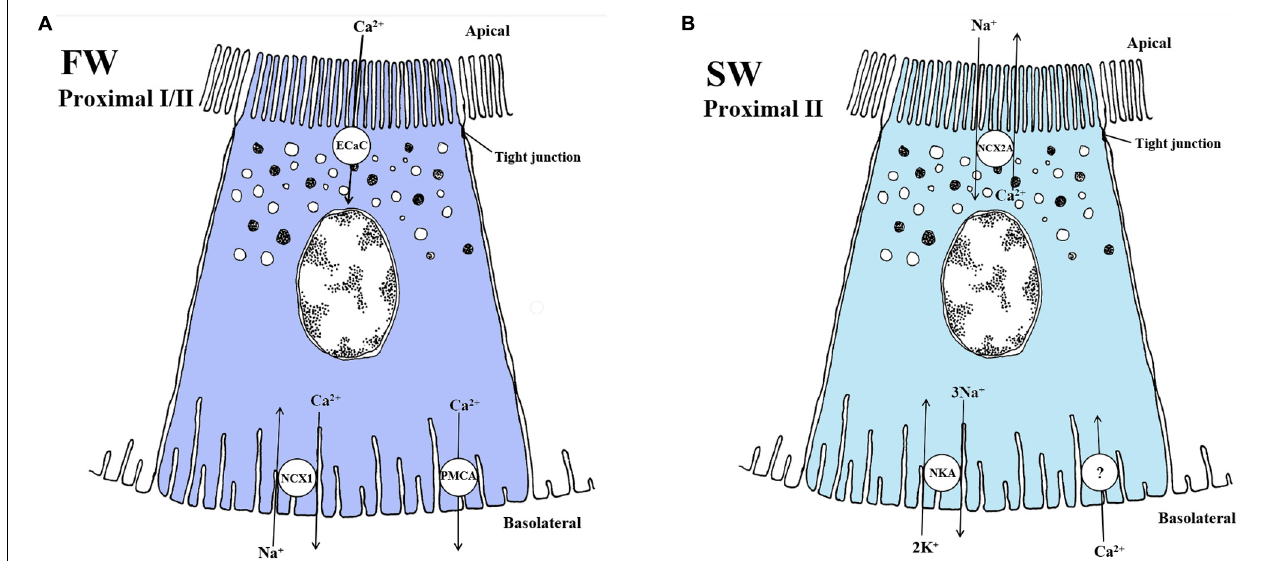
FIGURE 7 | Schematic overview showing localization and mechanisms of Ca 2 + transport in FW (A) and SW (B) teleosts. (A) In FW fish, the apically located Ca 2 + channel (ECaC/TRPV5/6) and the basolaterally located NCX1 exchanger Na + /Ca 2 + (NCX1, exchange ratio unknown) likely play a role in reabsorption of Ca 2 + in the fish kidney. The plasma-membrane Ca 2 + - ATPase also aids in mediating Ca 2 + transport from the cytosol to extracellular space, which have been reporter to have high enzyme activity in FW kidney. Thus, models are based on mechanisms in the fish gill and the mammalian kidney model. Understanding of the exact mechanisms is still very limited in the FW teleost kidney. (B) In SW fish, the secretion of Ca 2 + is mediated by the NCX2a in proximal tubule II exchanging Na + /Ca 2 + at the apical membrane. The negative membrane potential and the low intracellular Na + concentration generated by the Na + - K + -ATPase (NKA) are likely the driving forces for this transport. A basolateral Ca 2 + channel is necessary but has not yet been verified in the fish kidney. Models are based on the papers of Perry et al. (2003); Shahsavarani et al. (2006), Islam et al. (2011), and Sheetal et al.